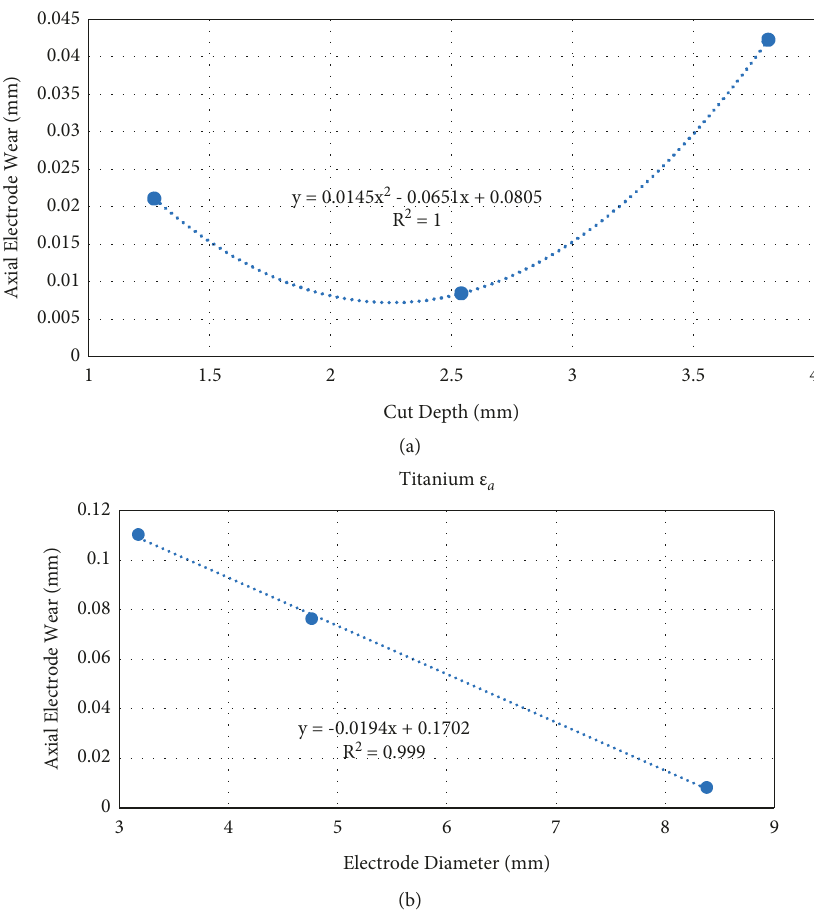
Figure 13: Mean ε a due to cut depth (a) and electrode size (b) in titanium.